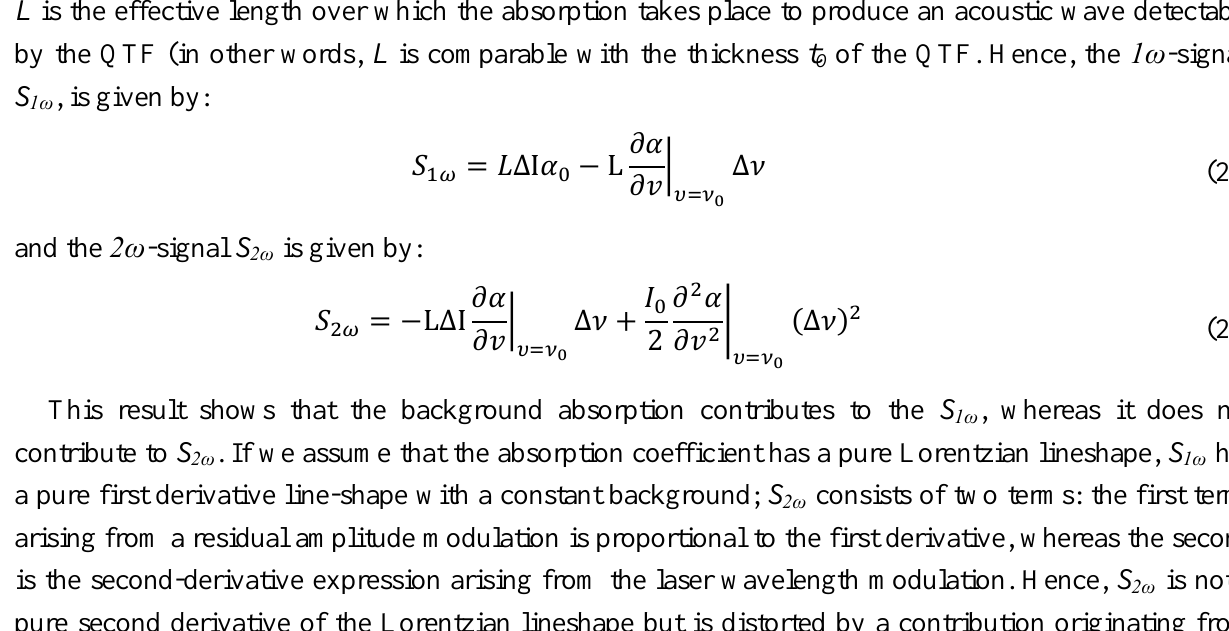
in N at a gas 2 2